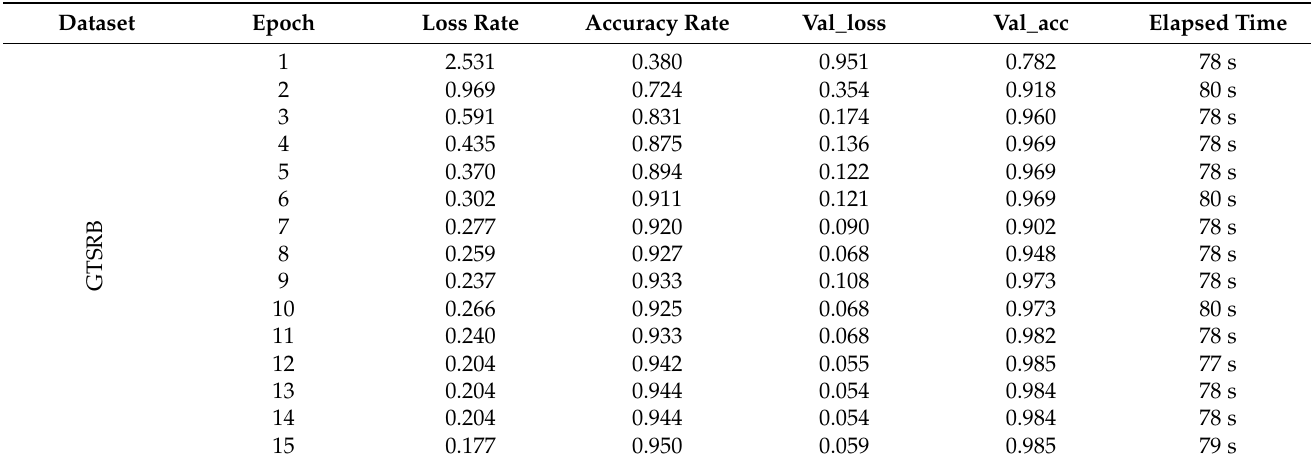
Table 1. ELVD model with a CNN trained dataset in 15 epochs.